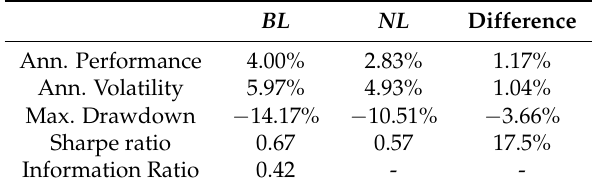
Table 10. Statistics for the BL and NL strategies. The Sharpe Ratio is calculated as the ratio between annualized performance and annualized volatility. For this case, the difference is given in relative terms. Data from January 2002 to June 2018.